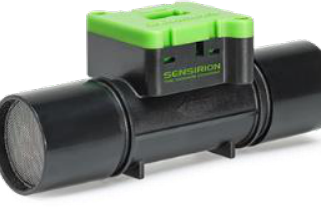
Figure 5. Mass-Flow Sensor